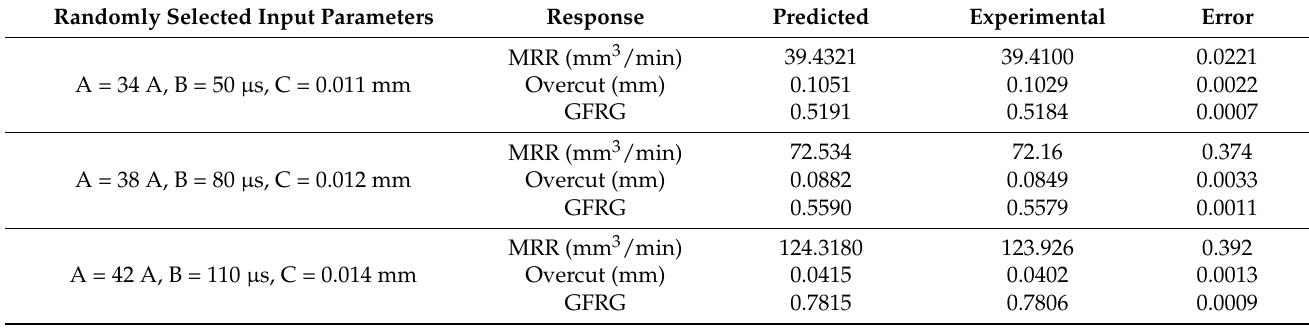
Table 11. Validation of regression